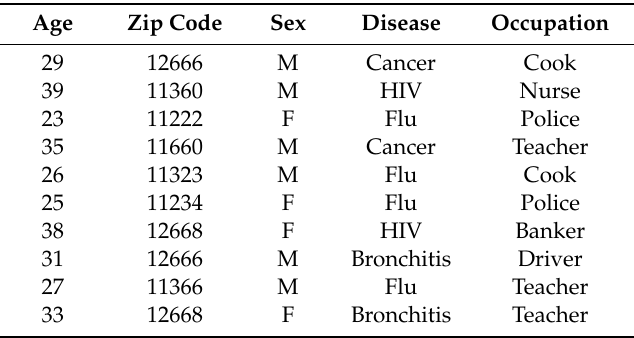
Table 10. Result of tuple